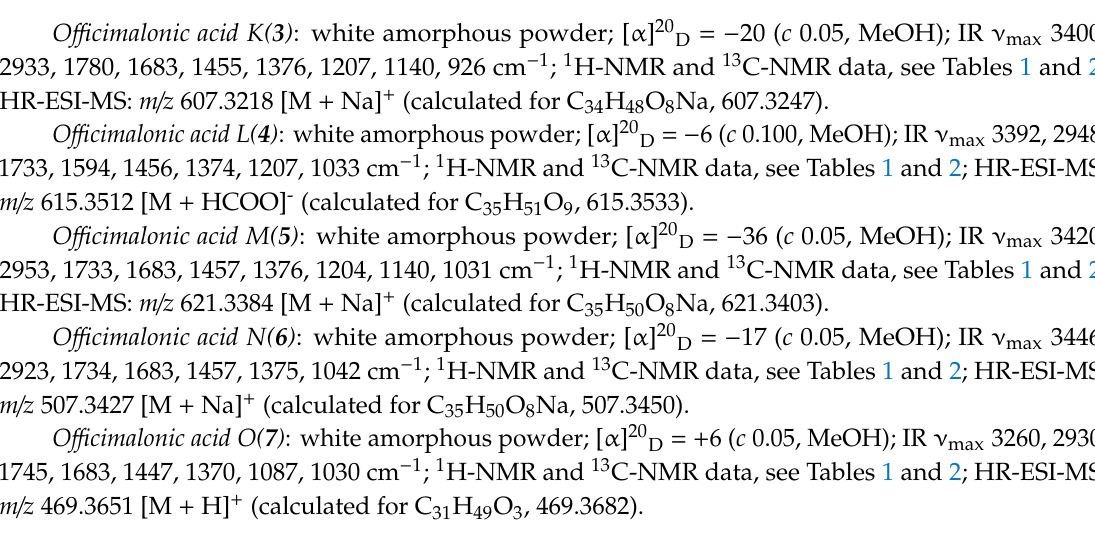
CDCl 3 . Figure S10: 13 C-NMR spectrum of o ffi cimalonic acid J ( 2 ) in CDCl 3 . Figure S11: HR-ESI-MS spectrum of o ffi cimalonic acid J ( 2 ). Figure S12: 1 H-NMR spectrum of o ffi cimalonic acid K ( 3 ) in CD 3 OD. Figure S13: